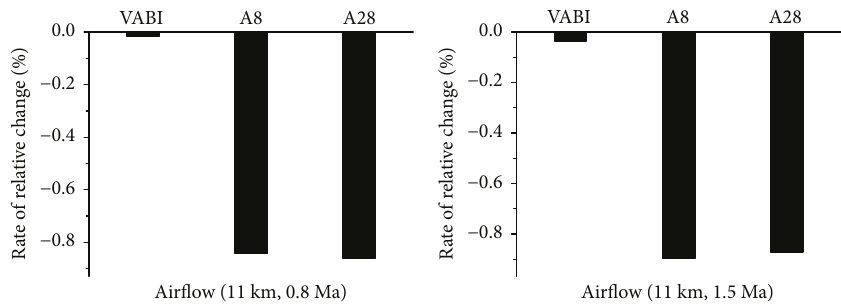
Figure 10: Sensitivity analysis of variable geometries on air fl ow (part 2).